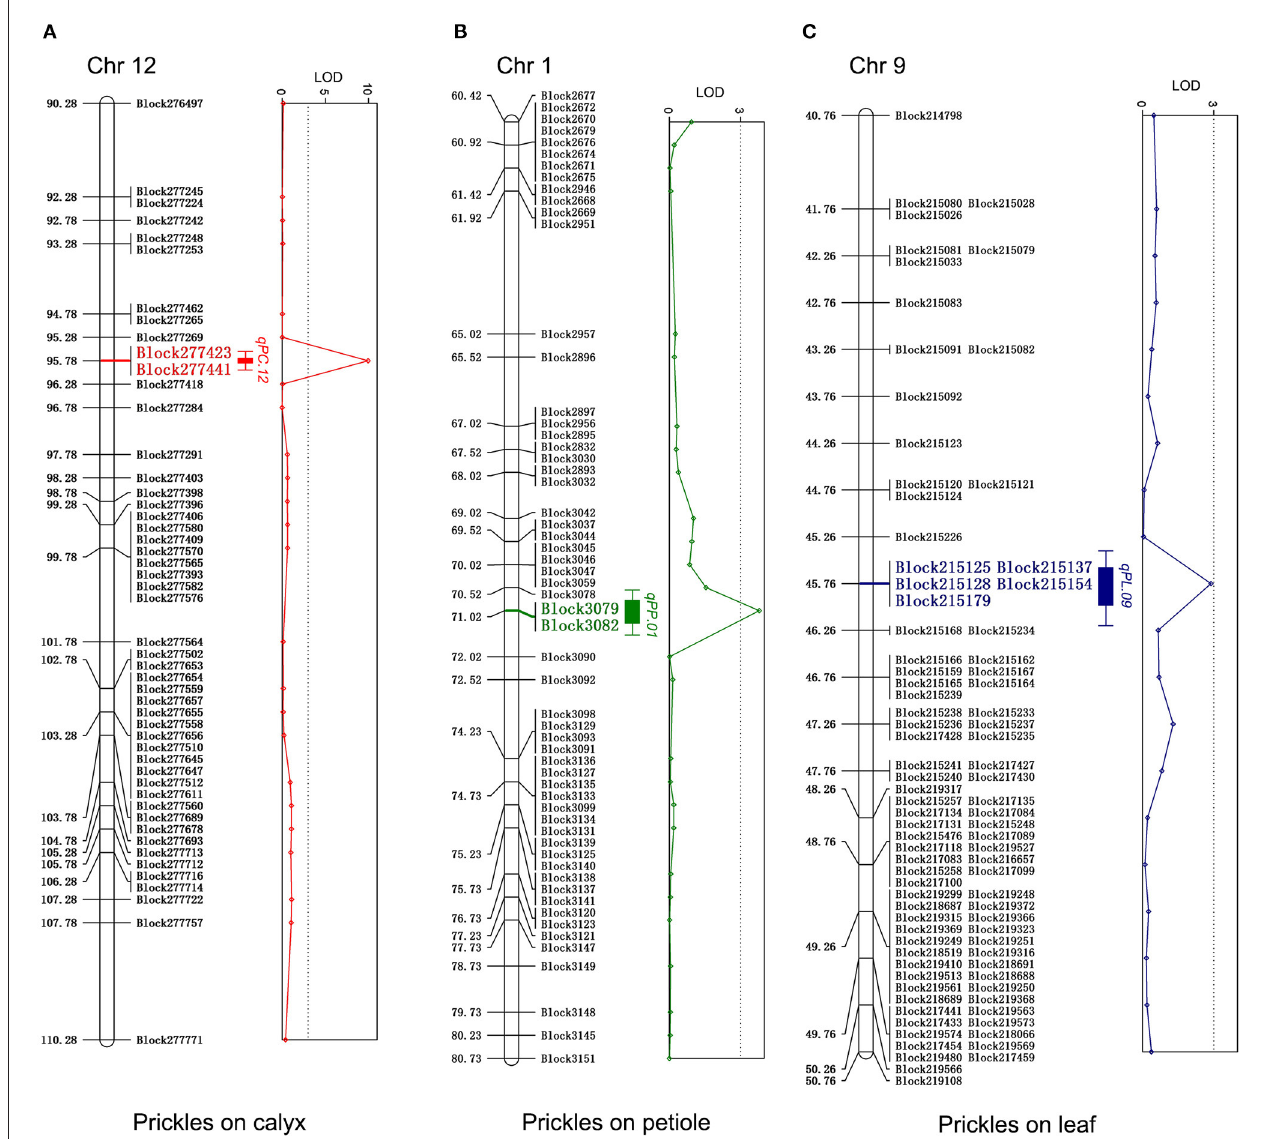
FIGURE 4 | Quantitative trait locus (QTL) regions associated with the number of prickles on calyx (A) , petiole (B) , and leaf (C) with the logarithm of odds (LOD) values of bin markers. The markers within QTL regions associated with the prickles on calyxes, petiole, and leaf were highlighted with red, green, and blue, respectively. The diagrams of LOD values were represented on the right.